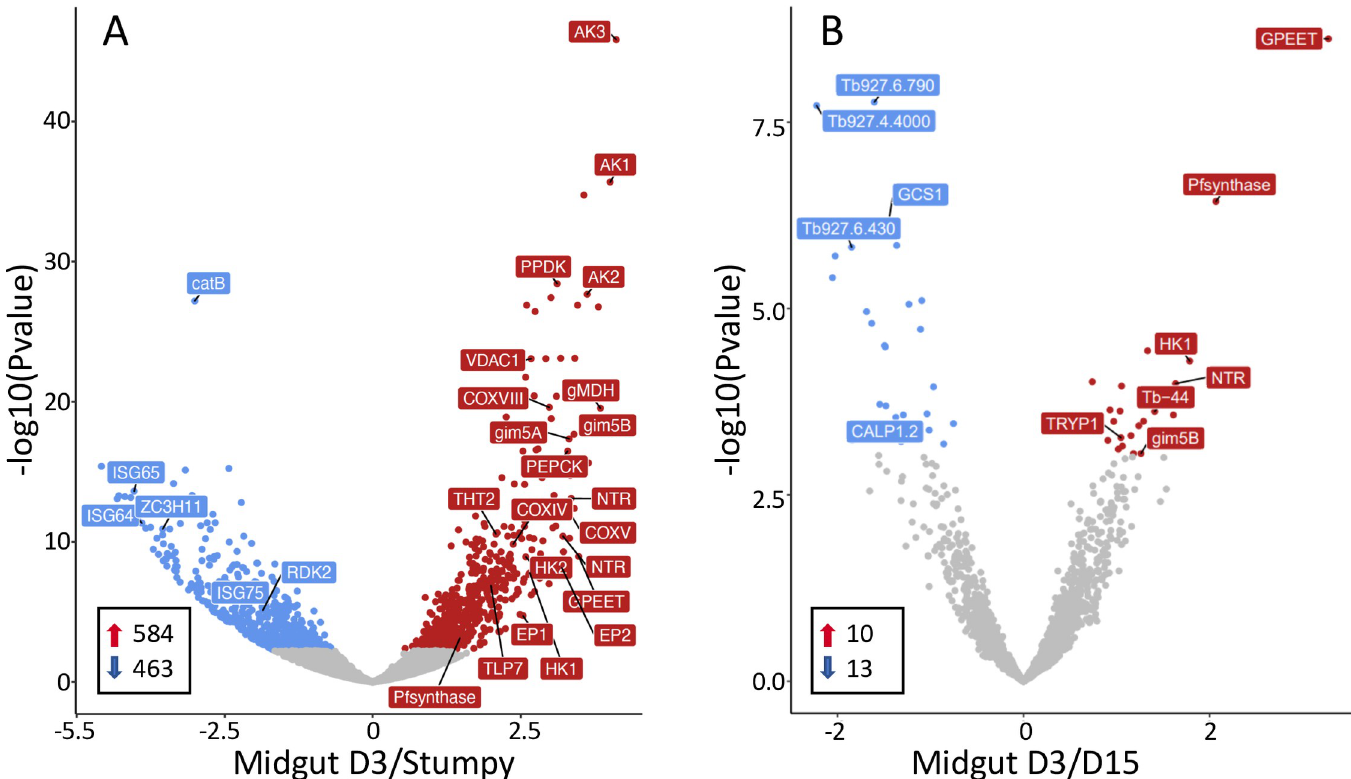
Fig 3. Volcano plots comparing the transcriptomes of A) culture-derived stumpy forms [10] and tsetse-derived midgut forms D3 post infection; B) midgut forms D3 versus D15. AK: arginine kinase; HK1: hexokinase 1; ISG: invariant surface glycoprotein; NTR: nitroreductase; PEPCK: phosphoenolpyruvate carboxykinase; PPDK: pyruvate phosphate dikinase; Tb-44: calflagin 44; THT2: high affinity hexose transporter. Red: Transcripts significantly upregulated on D3; blue: transcripts significantly downregulated on D3; grey: not significant. Red arrows: transcripts upregulated � 2-fold; blue arrows, transcripts downregulated �